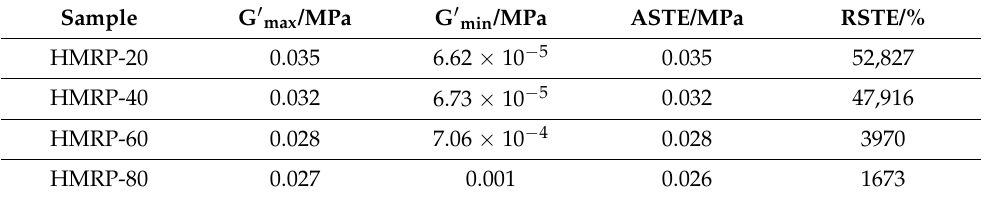
Table 2. G (cid:48) max , G (cid:48) min , ASTE, and RSTE of PVA-based MRP samples under shear frequency tests.